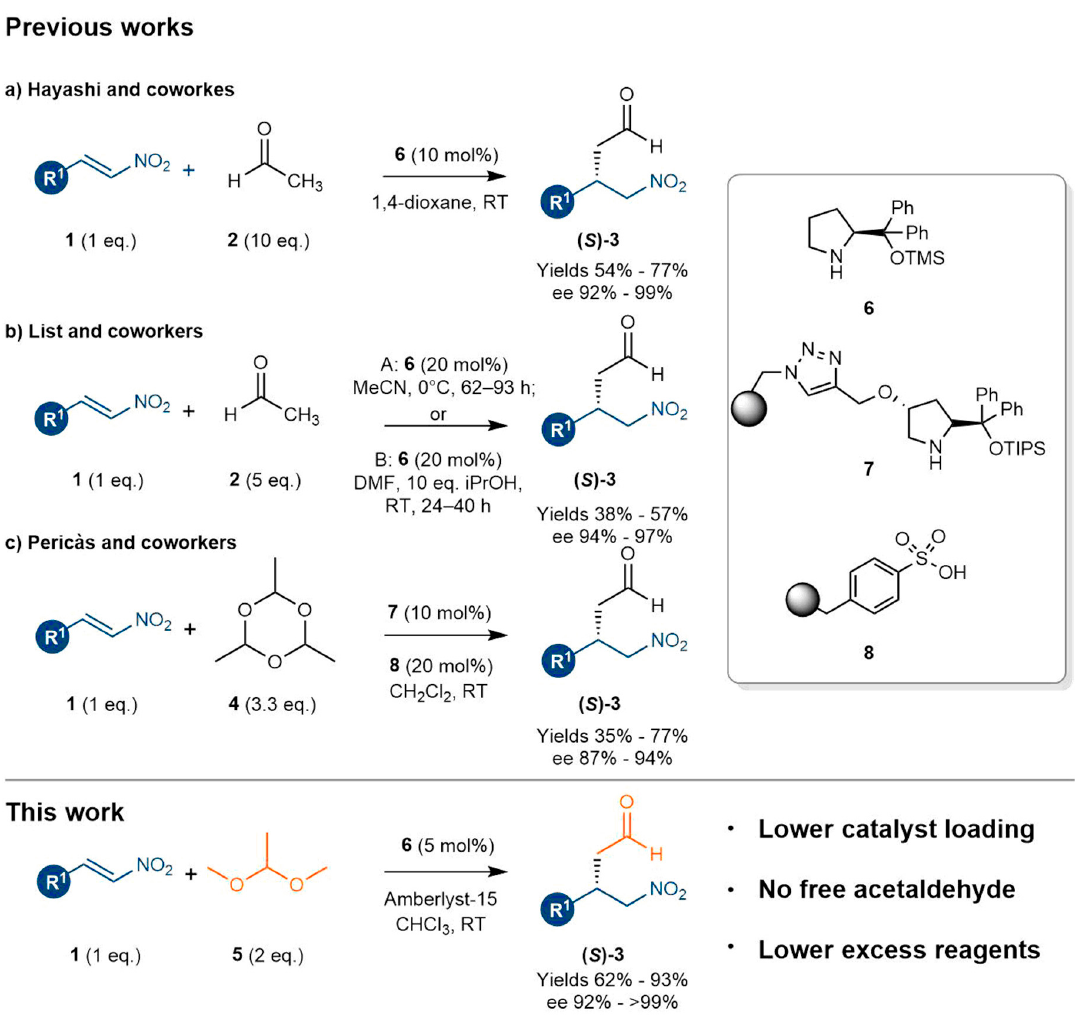
Scheme 1. Literature-reported examples of enantioselective Michael addition of acetaldehyde to nitroalkenes compared to our synthetic